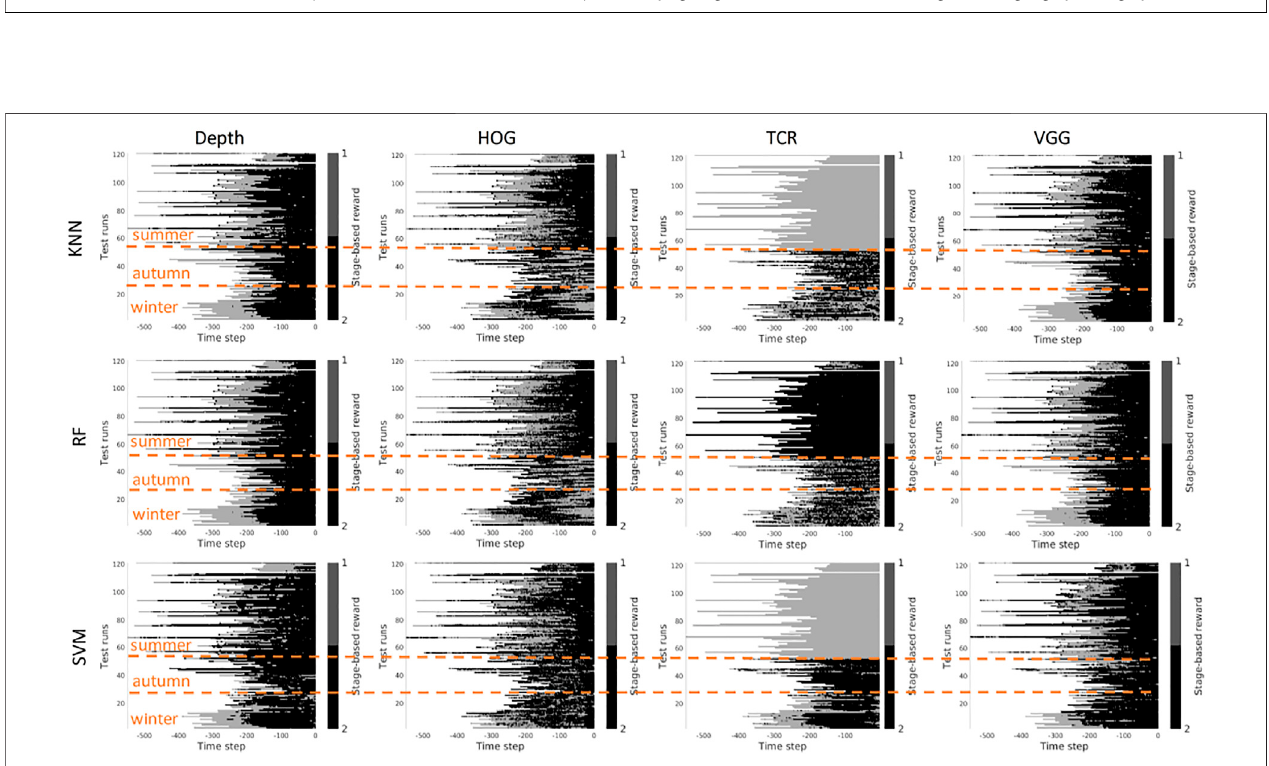
FIGURE 11 | Stage-based reward plotted for all seasons. Scenario 2: trained on the mixed set of data, 2 stages. The stages proceed as follows: S 1 − > S 2. x -axis stands for the time step in reversed order to match the samples of varying length. Color bar encodes the stages: S 1 -gray, S 2 - black.